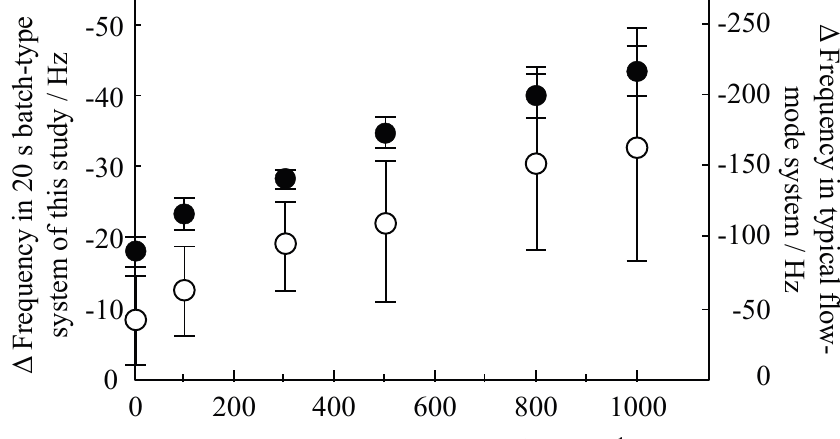
Figure 7. Analytical curve of frequency variation for different CRP concentrations from 0 to 1000 ng·mL − 1 : ( a ) batch-type system utilizing inkjet printing system ( ● ); ( b ) typical flow-mode system ( ○ ). Three values of Δ f at 20 s were averaged and plotted against sample